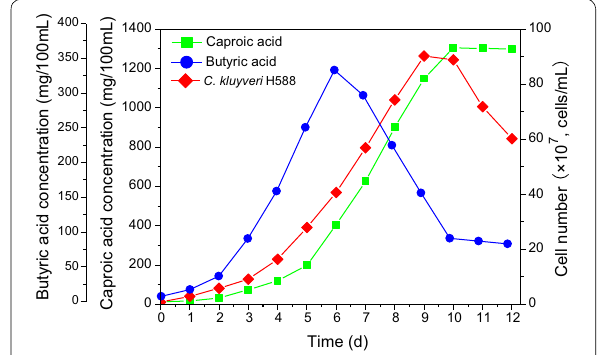
Fig. 6 Time courses of caproic acid production, butyric acid production and cell growth of C. kluyveri H588 during binary